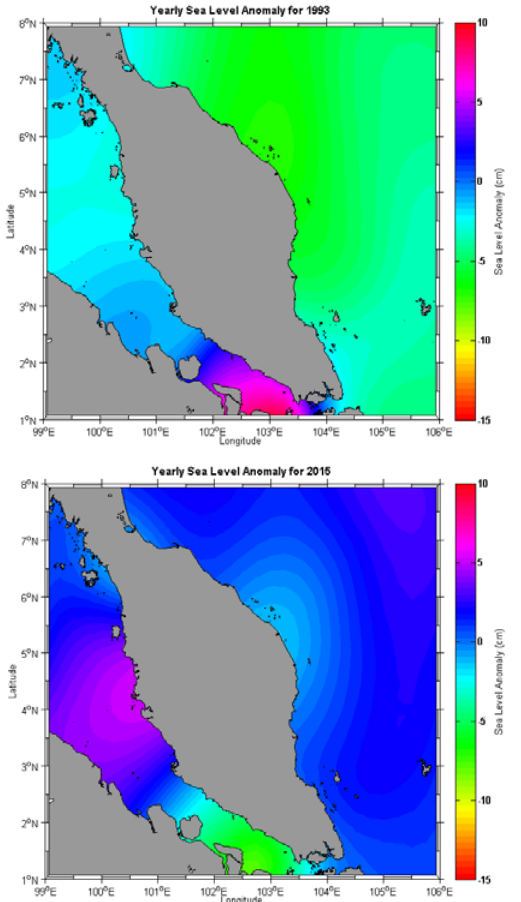
Figure 8. Map of yearly sea level anomaly over Malacca Straits and South China Sea for year 1993 (Up) and year 2015 (Down). Units are in cm.